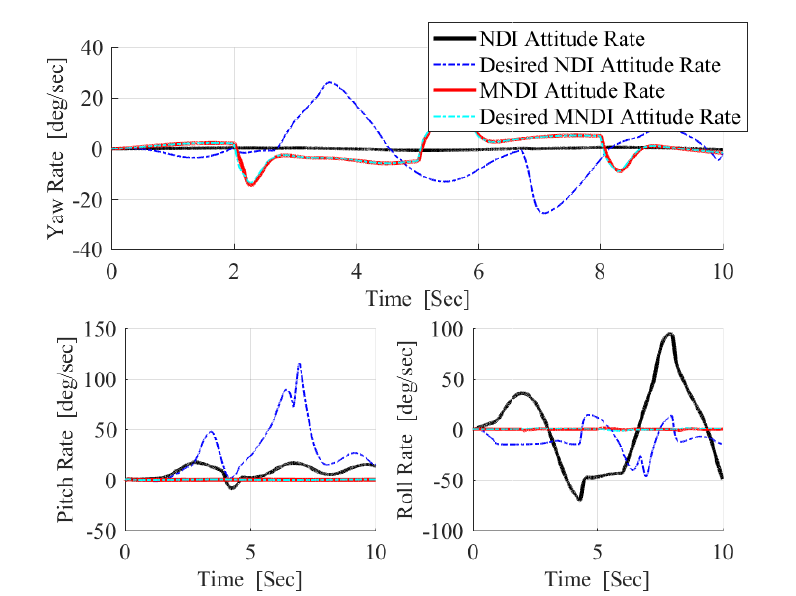
Figure 21. Inner loop rate response for outer side-slip angle excitation with wind and